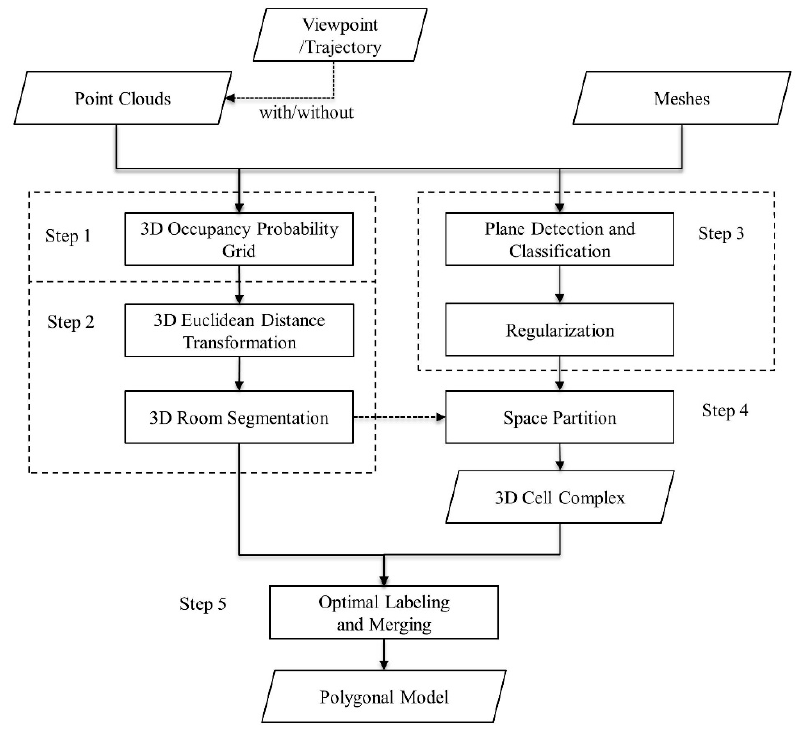
Figure 1. The flowchart of the proposed polygonal reconstruction method.